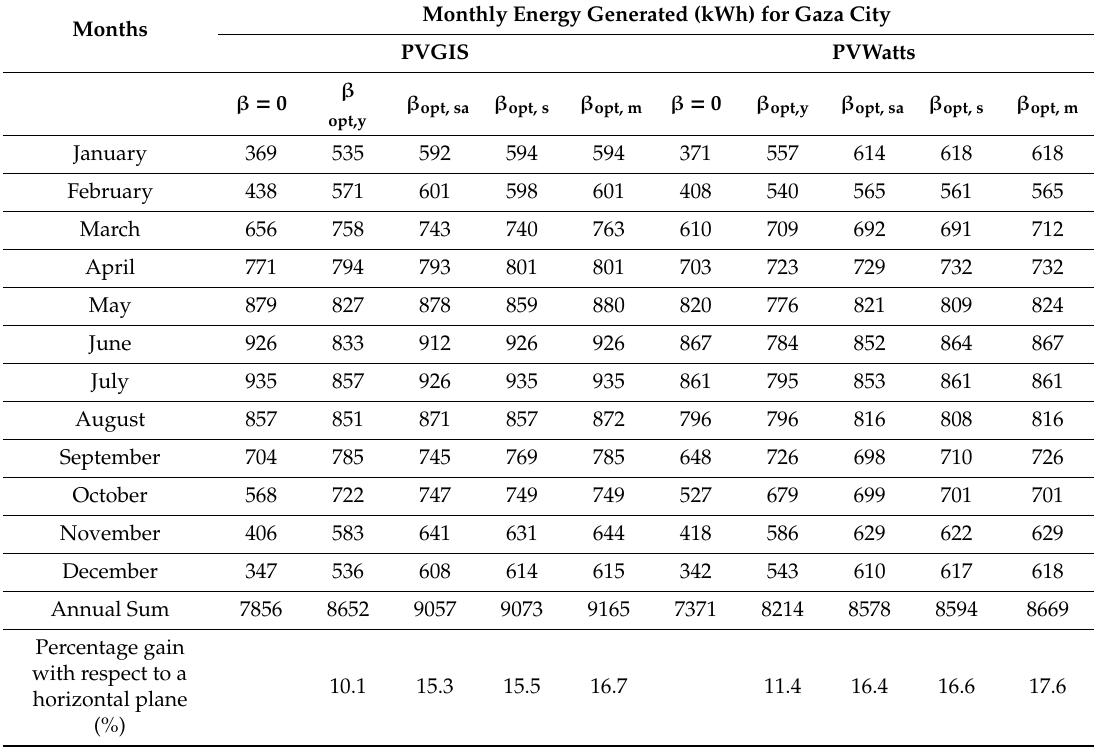
Table 18. Monthly energy generated by a 5 kWh system in Gaza